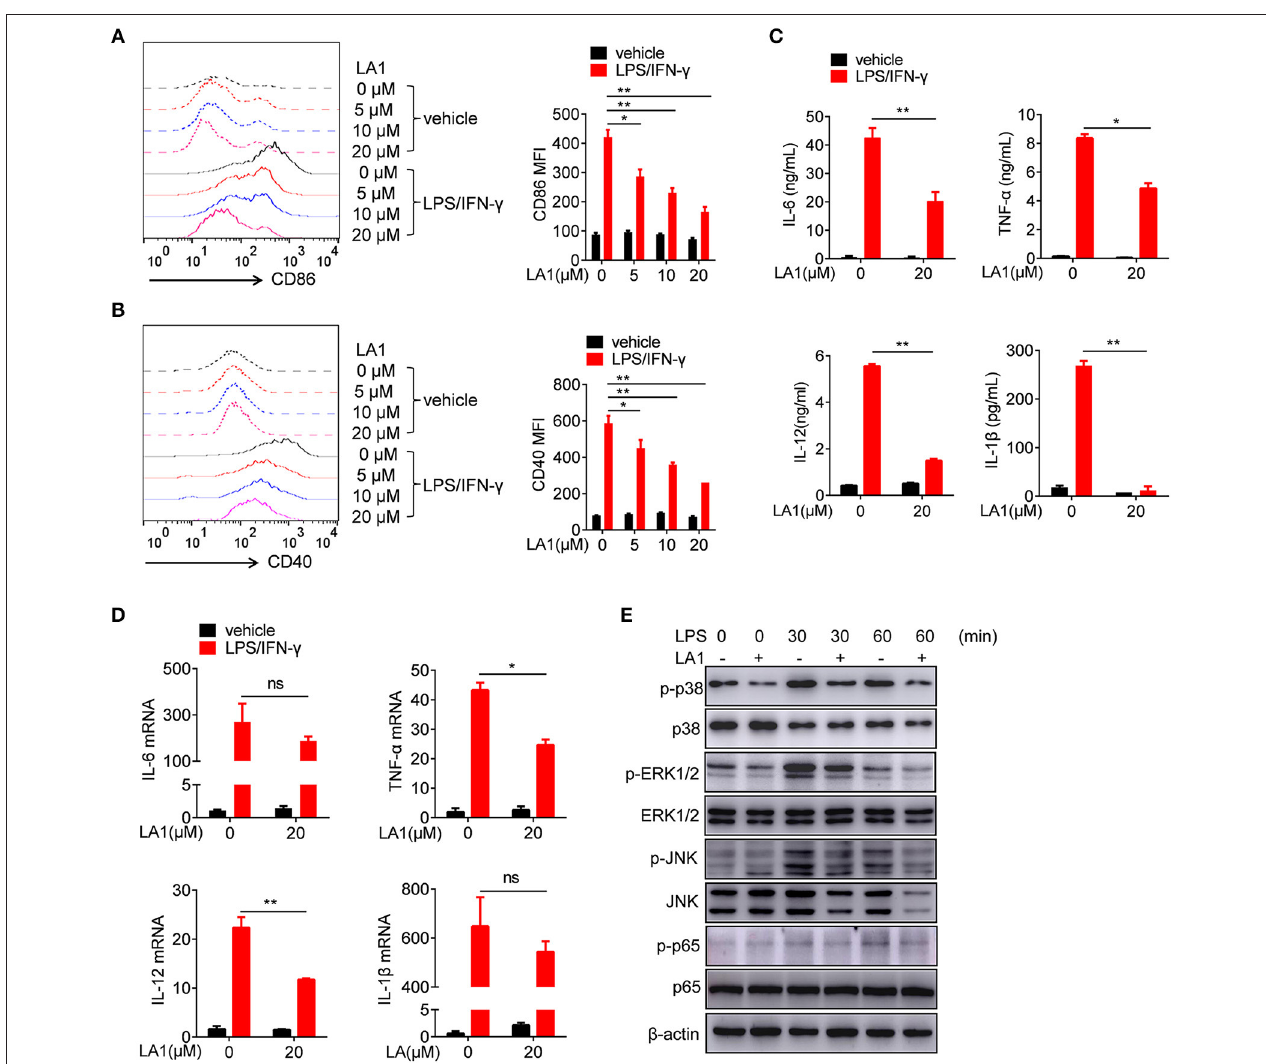
FIGURE 4 | Activation of CD11b by LA1 inhibited LPS/IFN- γ -induced pro-inflammatory response in macrophages in vitro . (A–D) BMDMs were pretreated with LA1 (0, 5, 10, and 20 µ M) for 2h, and then, the cells were treated with LPS (200ng/ml) and IFN- γ (10ng/ml). FACS analysis was performed to assess the expressions of CD86 (A) and CD40 (B) after 24h. Levels of IL-6, TNF- α , IL-12, and IL-1 β in supernatant were determined by ELISA after 24h (C) . Expressions of IL-6, TNF- α , IL-12, and IL-1 β were measured using qRT-PCR after 6h (D) . (E) BMDMs were pretreated with either 20 µ M LA1 or vehicle for 2h, and then, the cells were stimulated with LPS (200ng/ml) and IFN- γ (10ng/ml) for 30 and 60min. Cell lysates were prepared and subjected to immunoblotting with the indicated antibodies. β -actin was used as loading control. Data are representative from one out of three biological replicates, each with three technical replicates. Error bars represent S.E.M. * p < 0.05, ** p < 0.01, as determined by two-way ANOVA post-hoc Bonferroni Multiple Comparison Test; ns denotes p >